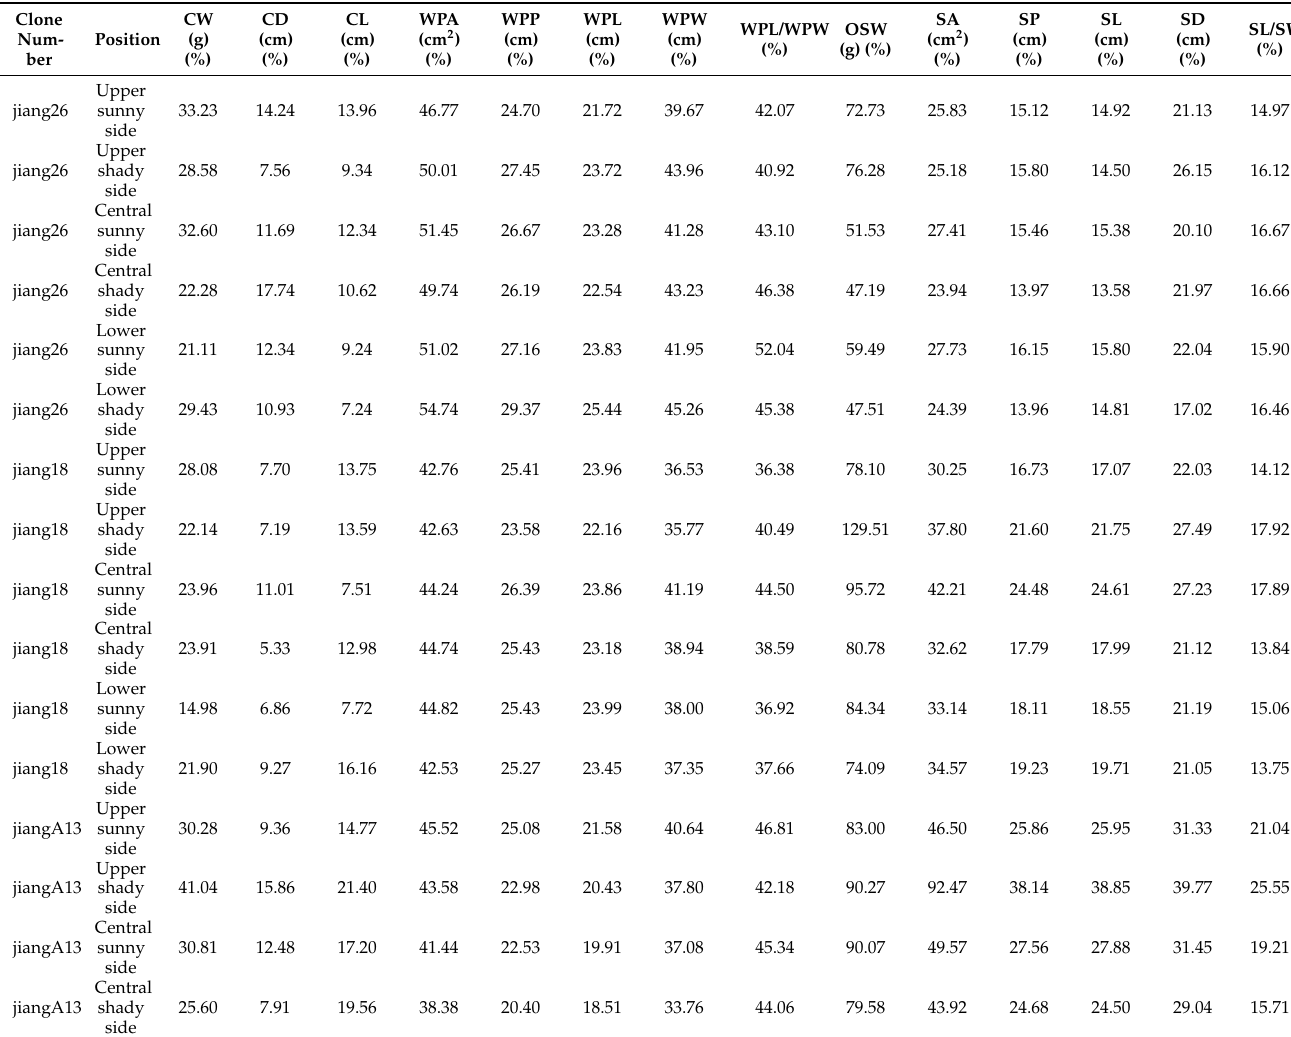
Table 6. Variation coefficients of phenotypic characters of bract scales and seeds from different crown layers of the three Chinese fir